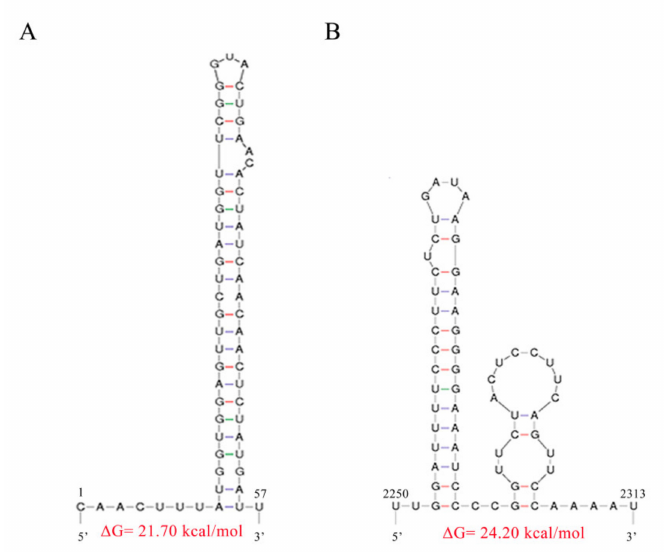
Figure 4. Predicted secondary structures of the terminal sequences of FodMV1. The 5´- and 3´- terminal sequences of the positive-strand of the dsRNA could be folded into potentially stable stem–loop structures. ( A ) Secondary structure of the 5 (cid:48) -UTR. ( B ) Secondary structure of the 3 (cid:48) -UTR. The MFOLD program was used to predict the secondary structure of the terminal sequences and to calculate the free